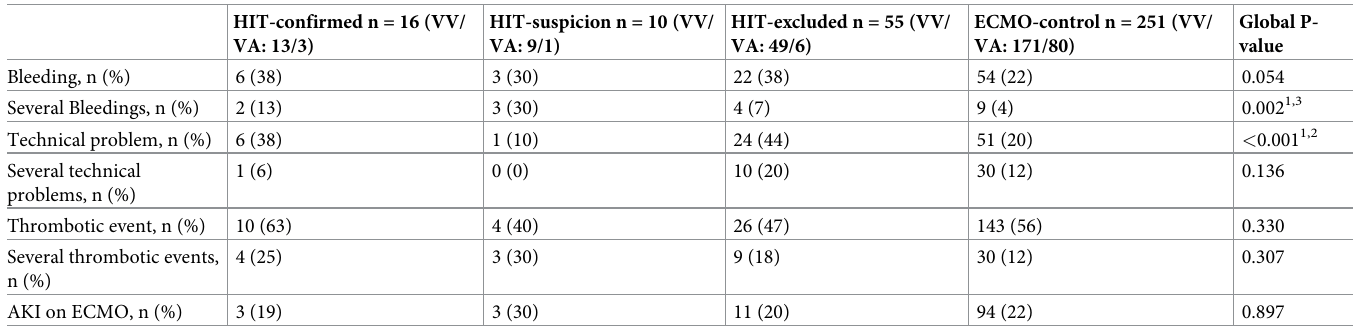
Table 2. Complications on extracorporeal membrane